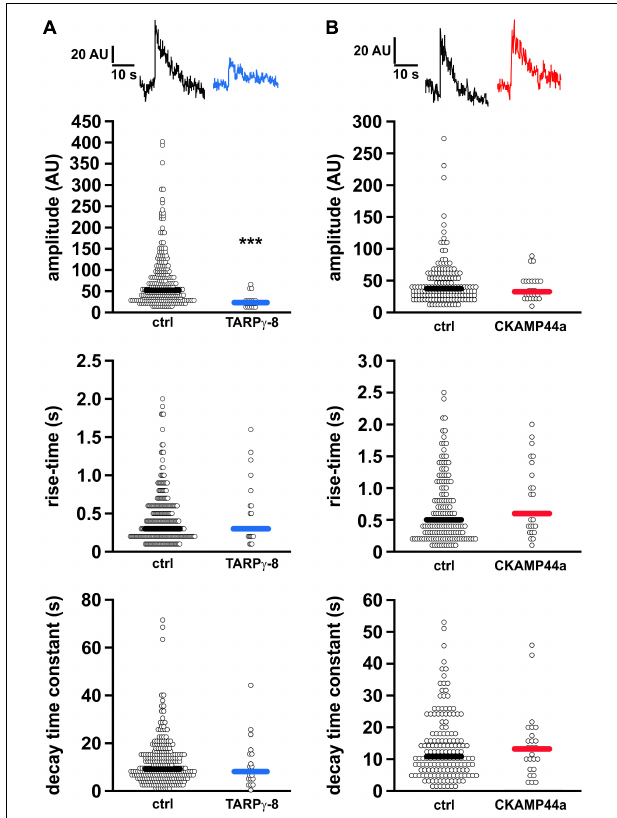
FIGURE 3 | Kinetic analysis of local SEP-fluorescence transients during receptor surface delivery. (A) Quantification of amplitude (upper panel) , rise time (middle panel) , and decay time constant (bottom panel) of the SEP-fluorescence transients observed during fusion events in controls (267 events) and neurons overexpressing TARP γ -8 (21 events). Shown are beeswarm plots of the binned data. The median values are indicated by the thick horizontal lines in each plot. Only the fluorescence amplitude of fusion events in neurons containing elevated TARP γ -8 levels was significantly reduced. (B) Analogous analysis for fusion events in neurons overexpressing CKAMP44a (25 events) and corresponding controls (156 events). Statistical analysis was performed using Mann–Whitney Rank Sum Test. *** p < 0.001.